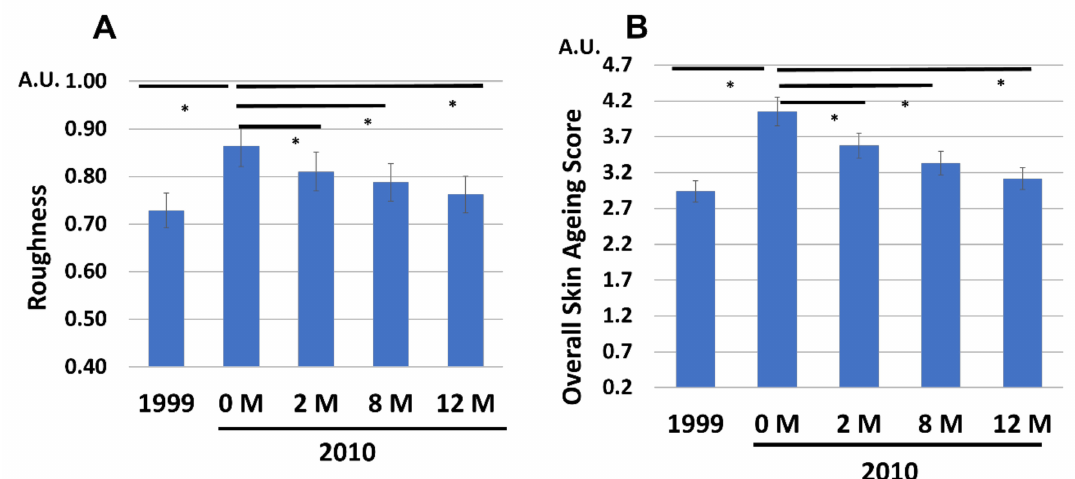
Figure 3. Chronological facial skin measurements in 1999 and in 2010 (at 0, 2, 8, and 12 M). All 86 subjects were treated with twice-daily application of G3 products for 12 M (0 M to 12 M). ( A ) Wrinkles. ( B ) Hyperpigmented spots. * p < 0.05.